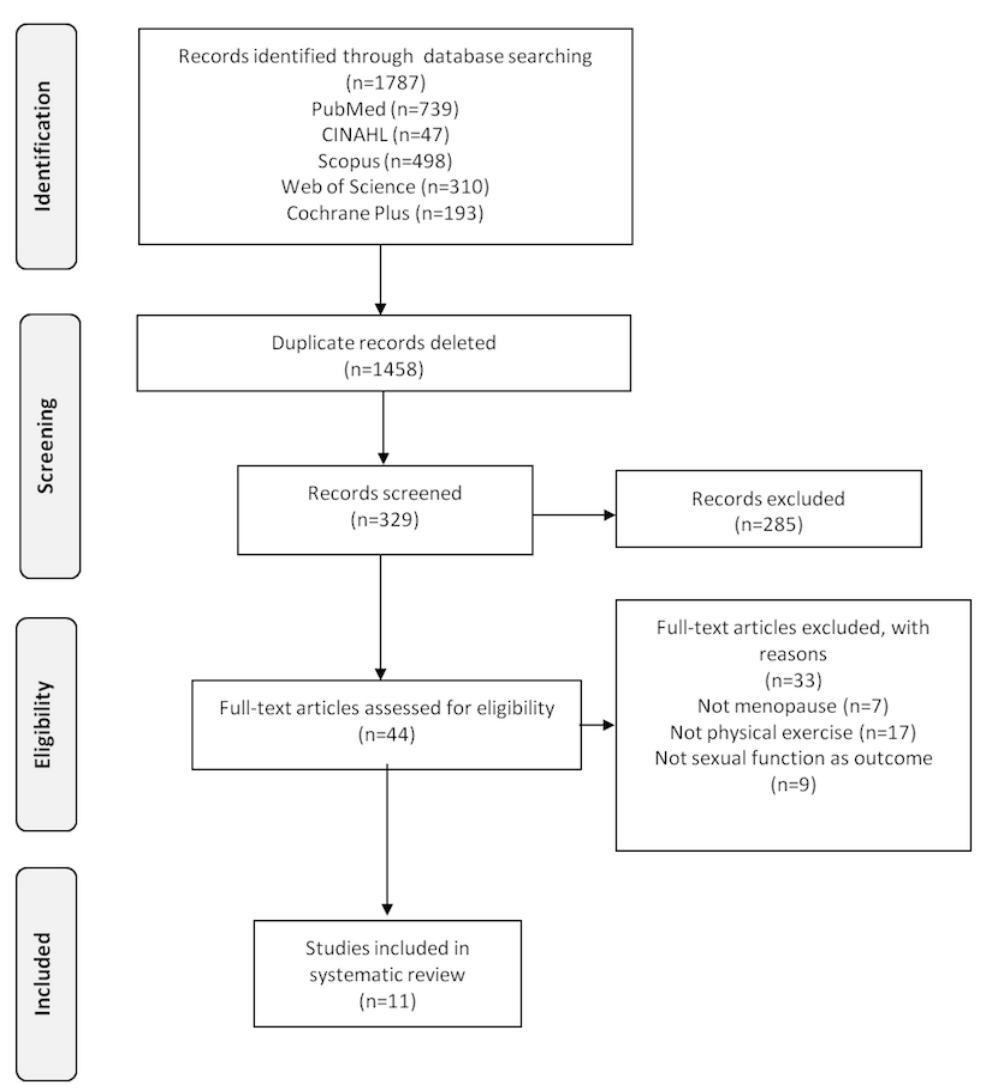
Figure 1. PRISMA flowchart showing the inclusion and exclusion of studies in this systematic review.